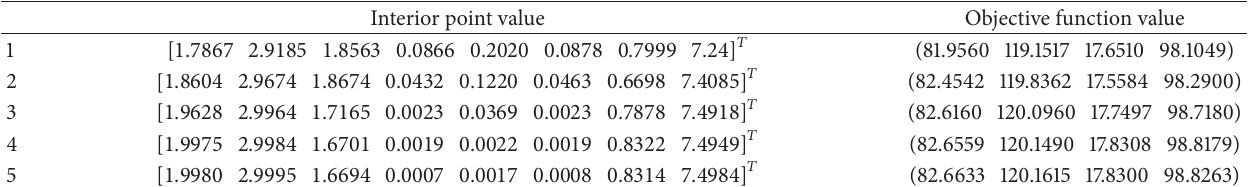
Table 2: The interior point value and the corresponding objective function value of each